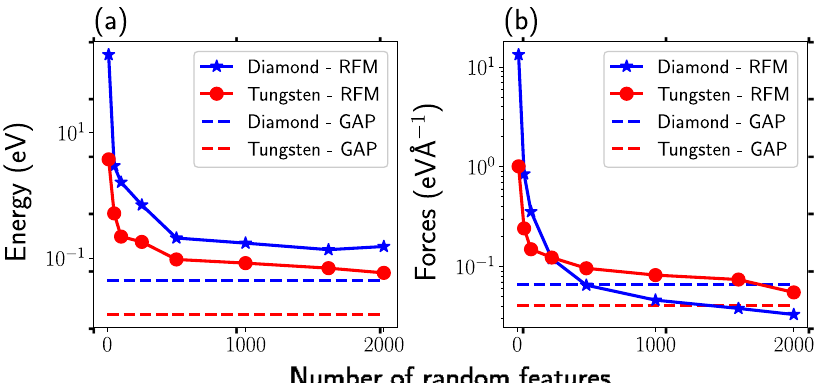
Fig. 3 Learning capacity of random features model. Dependence of MAE in energy and force prediction on the number of random features for RFM model. Mean absolute error in energy ( a ) and forces ( b ) are shown for diamond and tungsten RFM IP. Dashed horizontal lines show the performance of GAP IP.